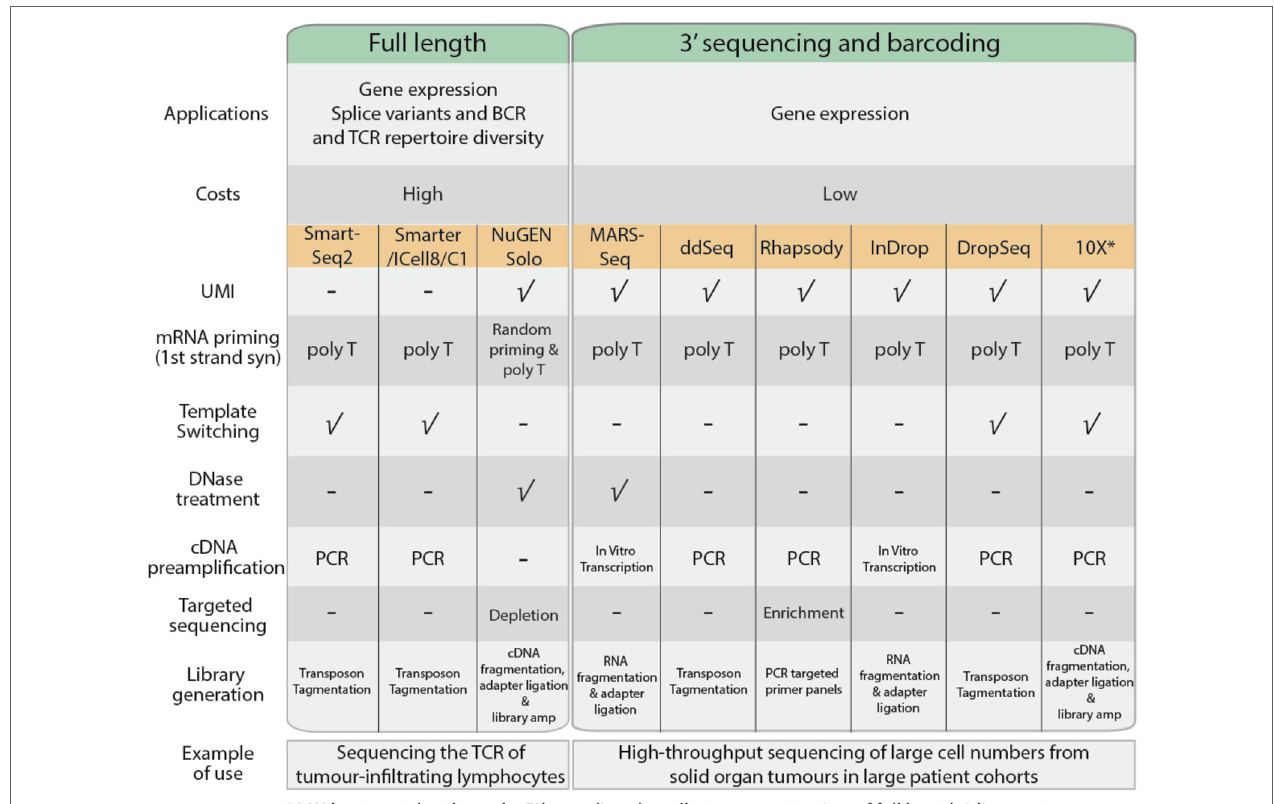
FigURe 3 | Comparison of common single cell RNA sequencing protocols, features, and their